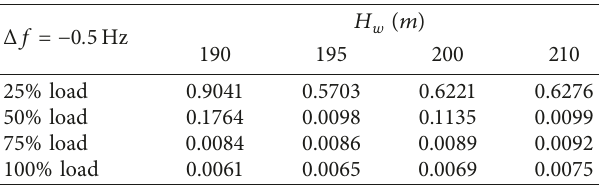
Table 6: The ITAE value of the output opening ITAE _y when Δ f � − 0 . 2Hz. Δ f � − 0 . 2Hz